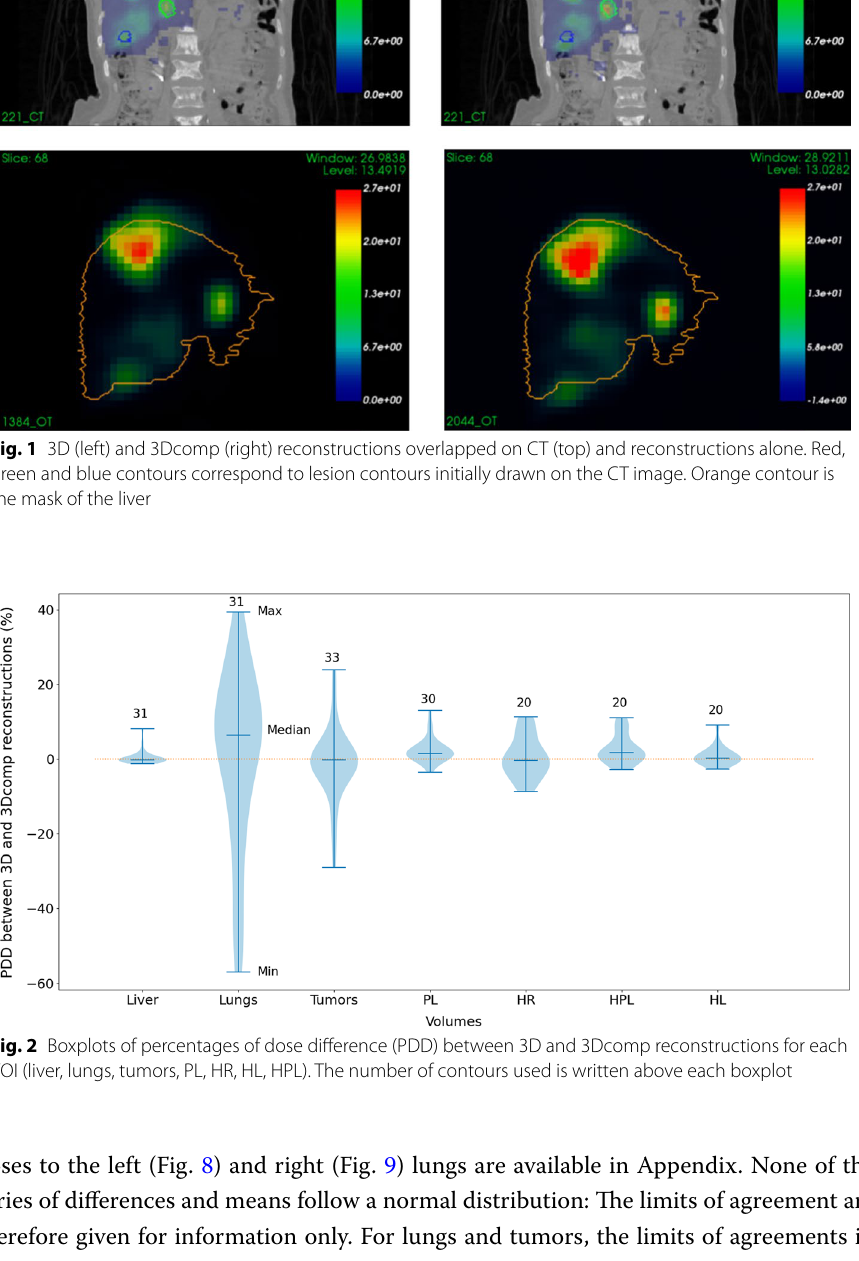
doses to the left (Fig. 8) and right (Fig. 9) lungs are available in Appendix. None of the series of differences and means follow a normal distribution: The limits of agreement are therefore given for information only. For lungs and tumors, the limits of agreements in the Bland–Altman plots were 2 Gy and 38 Gy. The data are available in Table 4 in Appen - dix. The mean, minimum and maximum doses estimated from the 3D reconstruction were 1.2 Gy, 0.06 Gy and 5.8 Gy for the left lung and 4.7 Gy, 0.2 Gy and 14.3 Gy for the right lung. There was no statistically significant difference for each lung with and with- out correction for respiratory motion (Wilcoxon’s test: p value > 0.05). No statistically